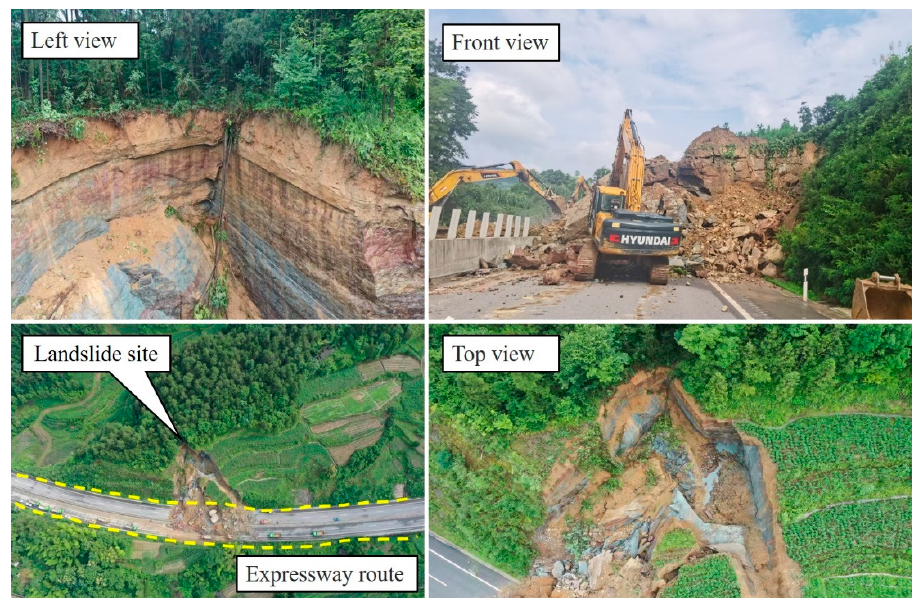
Figure 2. The highway geological landslide.